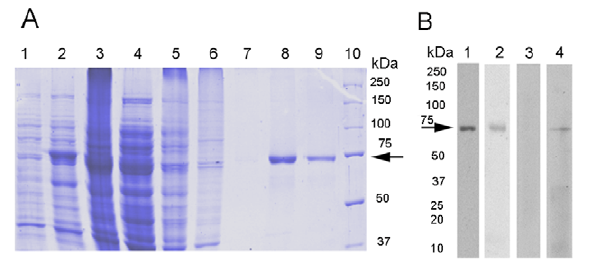
Figure 2. Heterologous expression and purification of E. histolytica family A DNA polymerase. ( A ) Coomassie blue stained SDS-PAGE (10%) gel showing the expression and purification of EhDNApolA. Lane1, uninduced pCOLD-EhDNApolA construct; lane 2, IPTG induced sample; lane 3, insoluble fraction; lane 4, soluble lysate; lane 5, nickel agarose flow-through; lane 6, 35 mM imidazol wash; lane 7, 50mM imidazol wash; lane 8, nickel agarose column eluate; lane 9, phosphocelulose column eluate; lane 10, molecular weight standards. ( B ) Detection of recombinant and endogenous EhDNApolA.Recombi- nant EhDNApolA and total extracts of E. histolytica were resolved by SDS-PAGE (15%), electroblotted onto nitrocellulose membrane, and immunoblotted with diverse antibodies. Lane 1, recombinant EhDNA- polA treated with commercial anti-6 histidines antibody; lane 2, recombinant EhDNApolA treated with mouse antibodies raised against an epitope of EhDNApolA; lane 3, total protein extracts of E. histolytica treated with preimmune serum; lane 4, total protein extracts of E. histolytica treated with specific mouse antibodies raised an epitope of EhDNApolA.